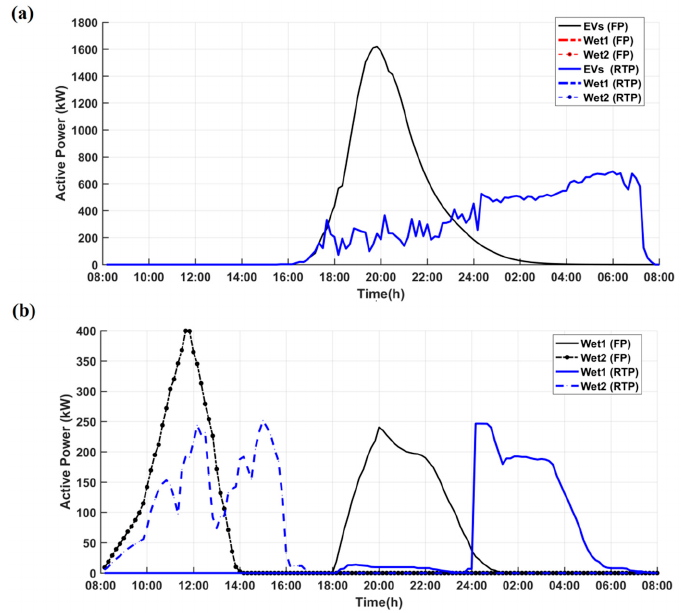
Figure 7. The total active power of elastic loads in FR and the RTP (the proposed method), ( a ) total power of EVs; ( b ) Total active power of other elastic loads.